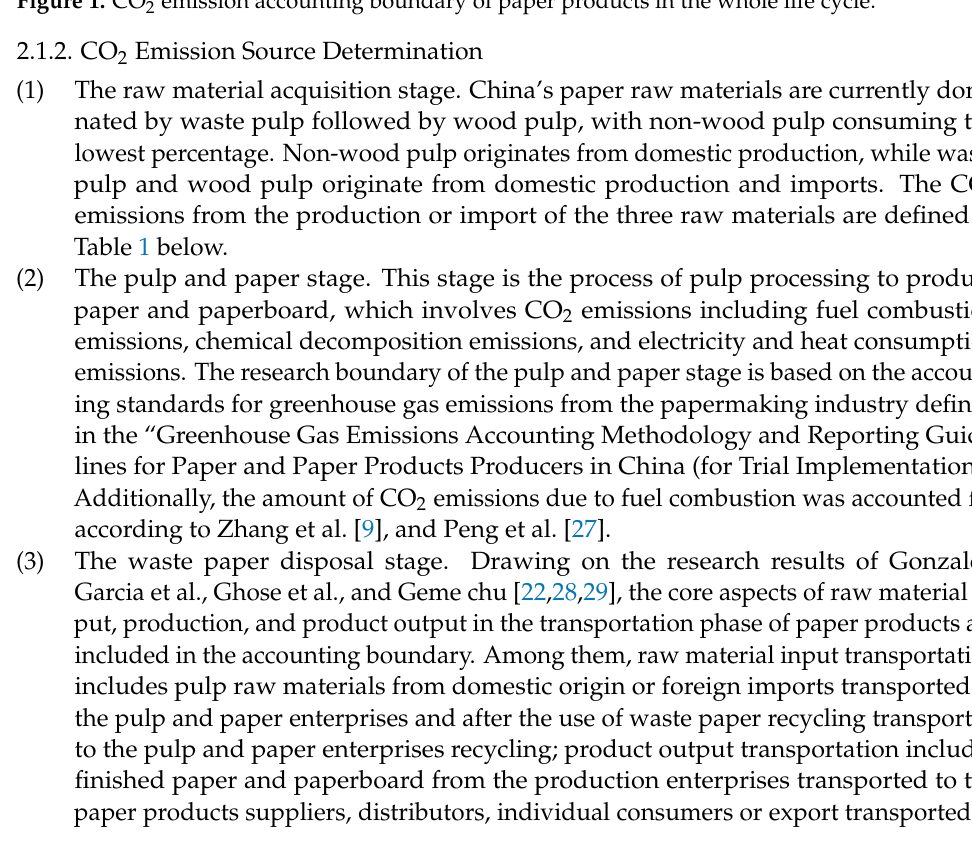
Figure 1. CO 2 emission accounting boundary of paper products in the whole life cycle.